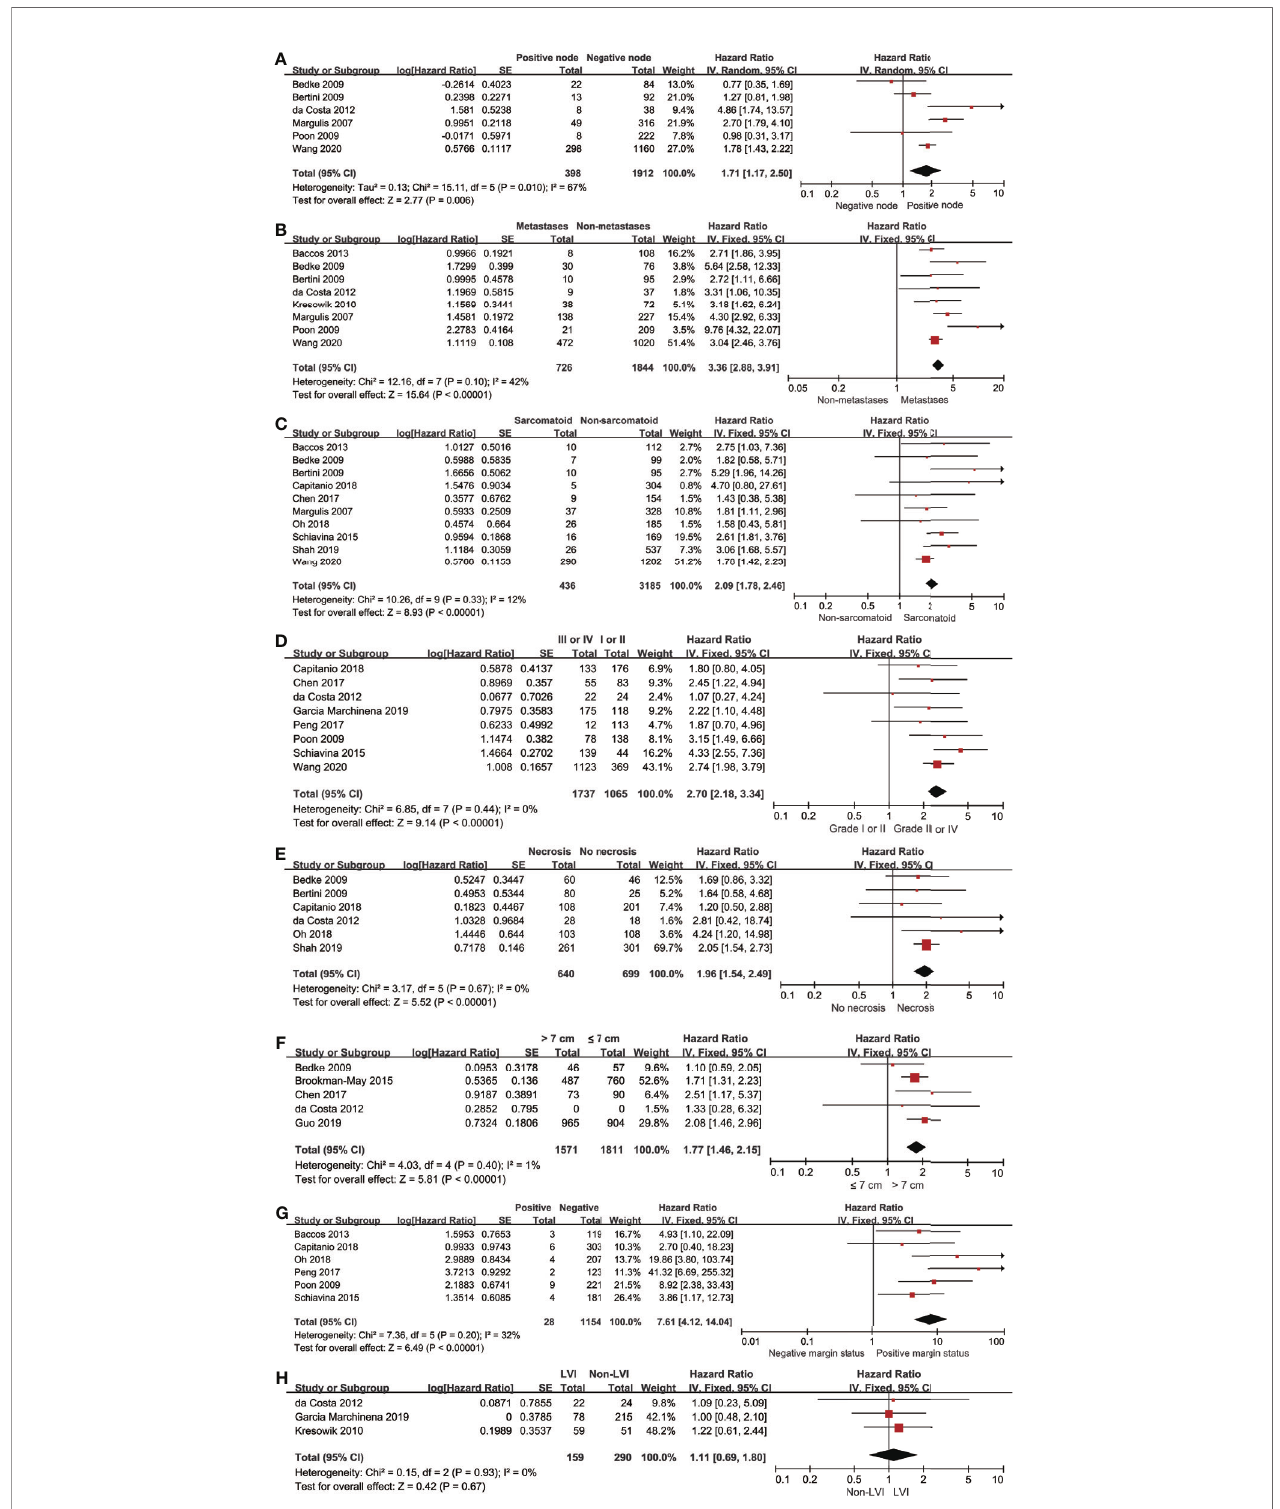
FIGURE 4 | Forrest plots of Hazards ratio (HR) evaluating the signi fi cant predictors of cancer-speci fi c survival for different pathological features of pT3a. (A) : lymph node involvement; (B) : distant metastases; (C) : sarcomatoid differentiation; (D) : Fuhrman grade (III, IV vs I, II); (E) : tumor necrosis; (F) : tumor size (>7 cm vs ≤ 7cm); (G) : positive margin status; (H) : lymphovascular